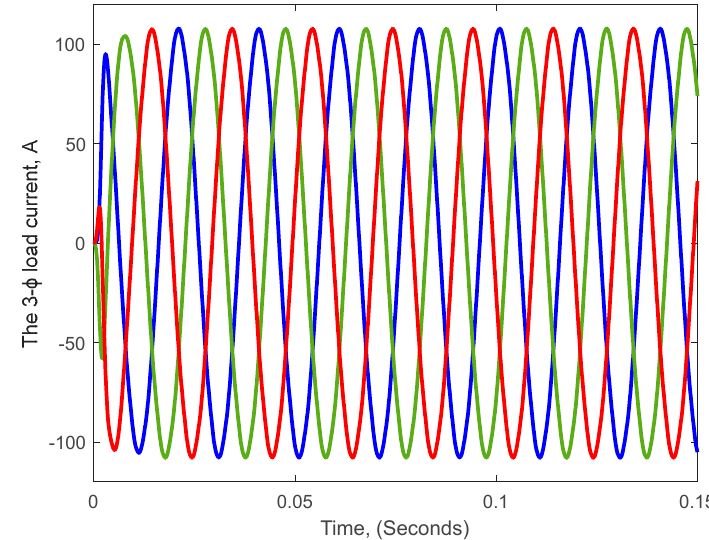
Figure 9. The output load currents.